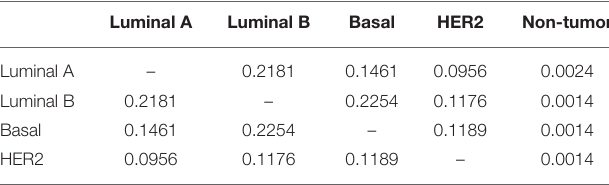
TABLE 3 | Jaccard indexes for each pair of transcriptional network link sets. Luminal A Luminal B Basal HER2